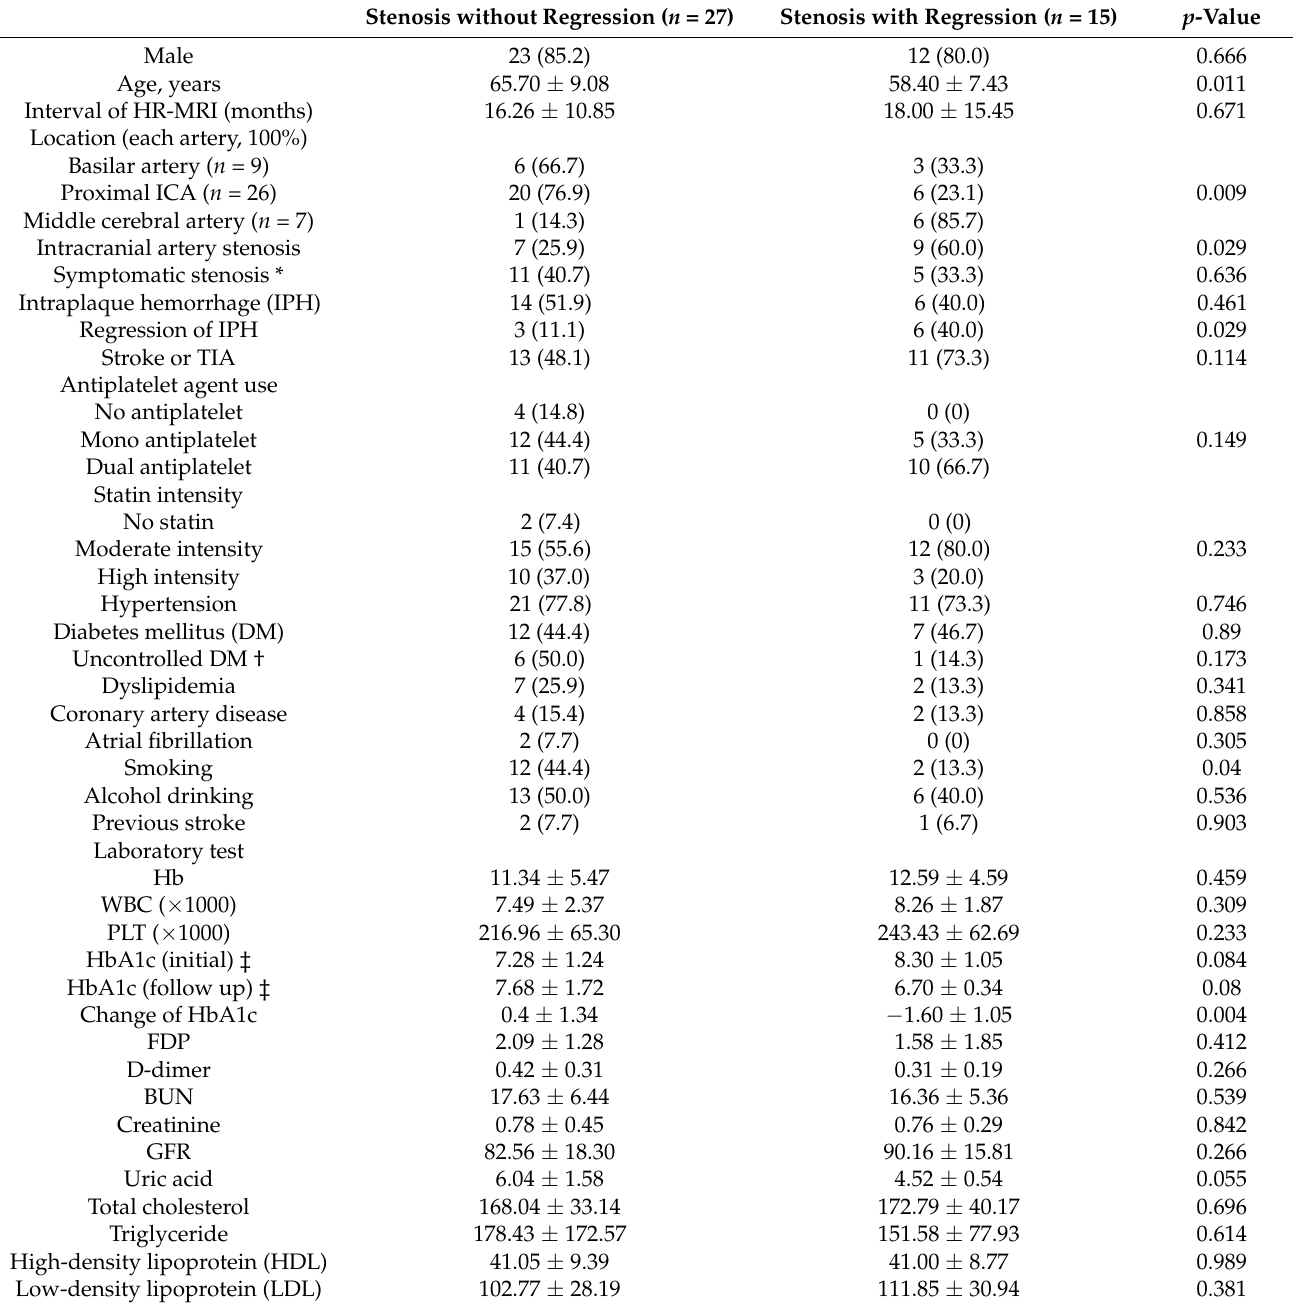
Table 2. Comparison of the demographics of patients according to regression in cerebral artery stenosis. Stenosis without Regression ( n = 27) Stenosis with Regression ( n =